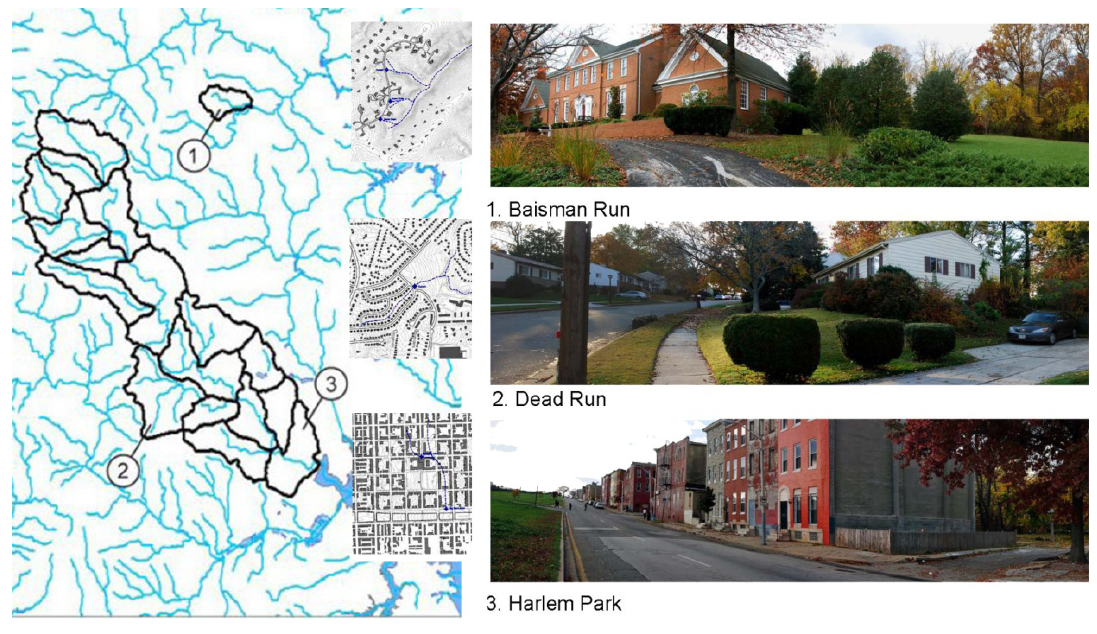
Figure 2. The Gwynn’s Falls Watershed framework of the Baltimore Ecosystem Study cuts across political boundaries and links sites as diverse as reserve forestlands, posh suburbs, older ranch house neighborhoods, row house blocks, and industrial brownfields. (Courtesy of